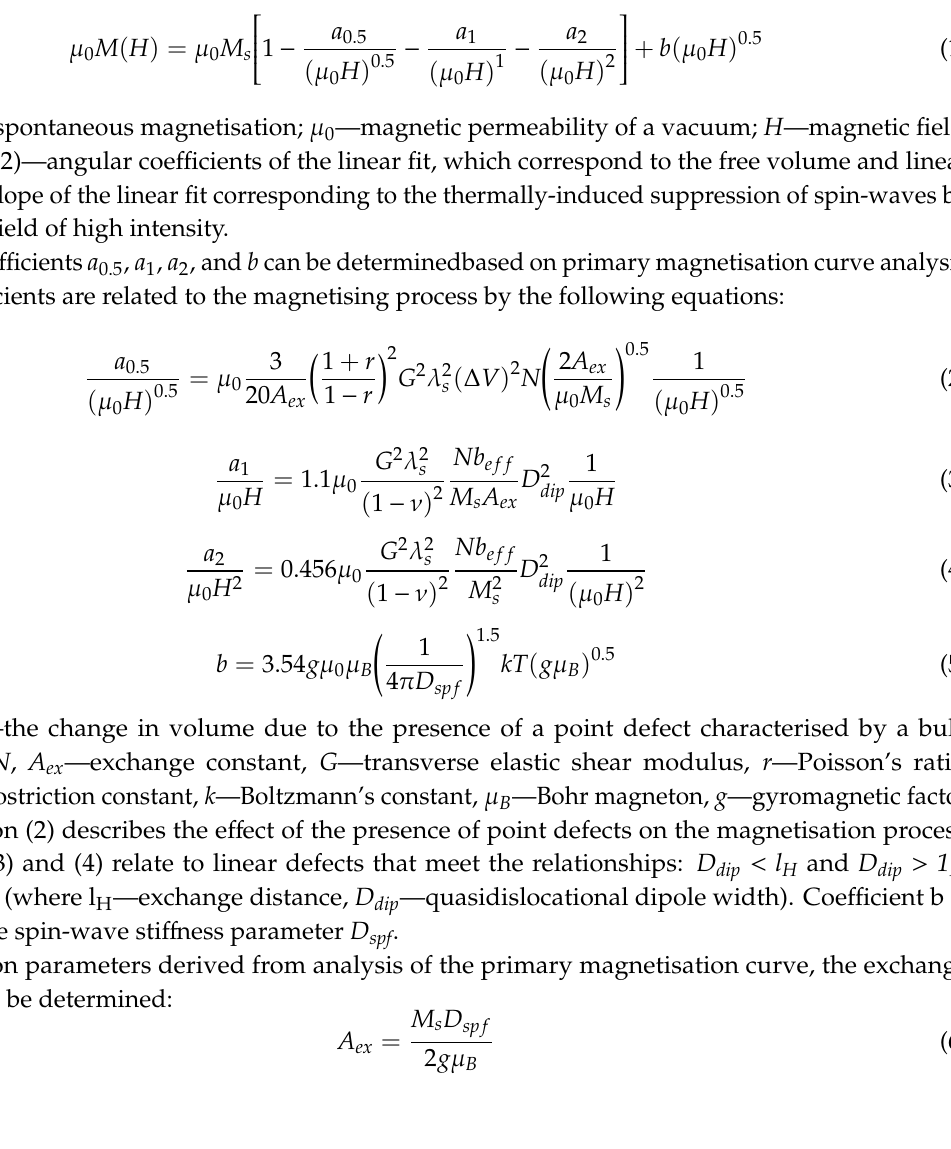
Table 1. Data from the analysis of X-ray di ff raction patterns. Width of the Maximum Alloy (deg)